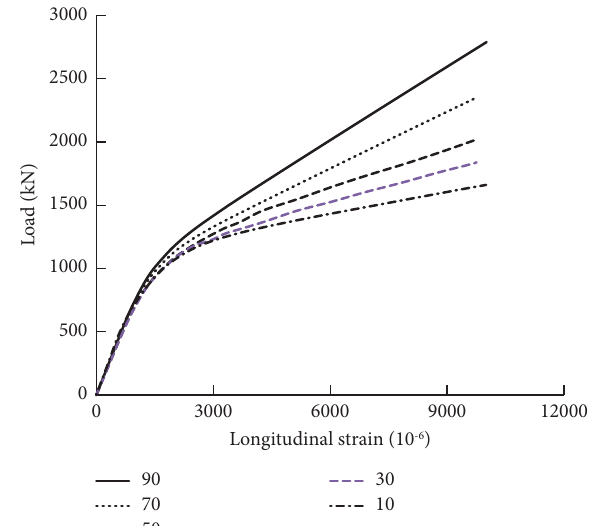
Figure 12: Te infuence of the GFRP tube fber winding